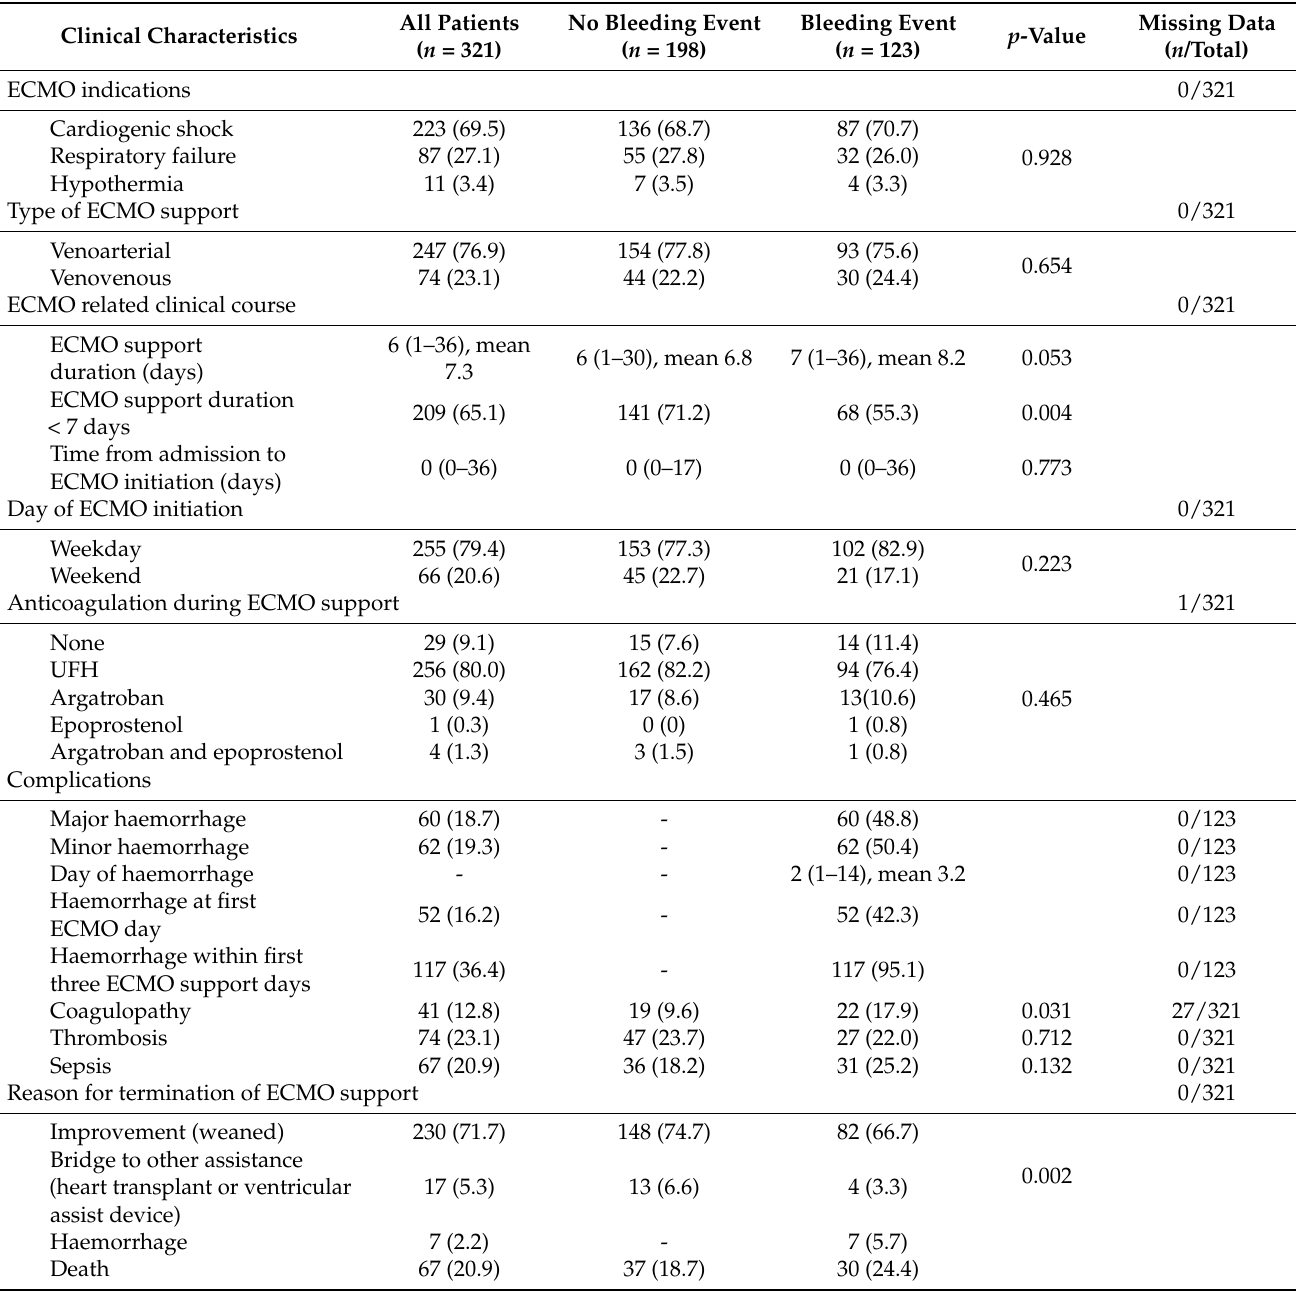
Table 2. ECMO related characteristics and complications ( n =